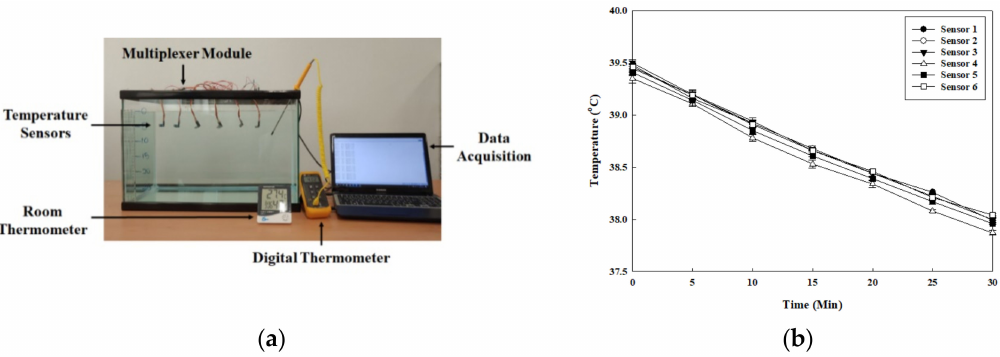
Figure 3. Experiment for observing water temperature variation in di ff erent locations at the same depth: (a) picture of the experiment; (b) results of water temperature variation in di ff erent locations at the same depth over time.